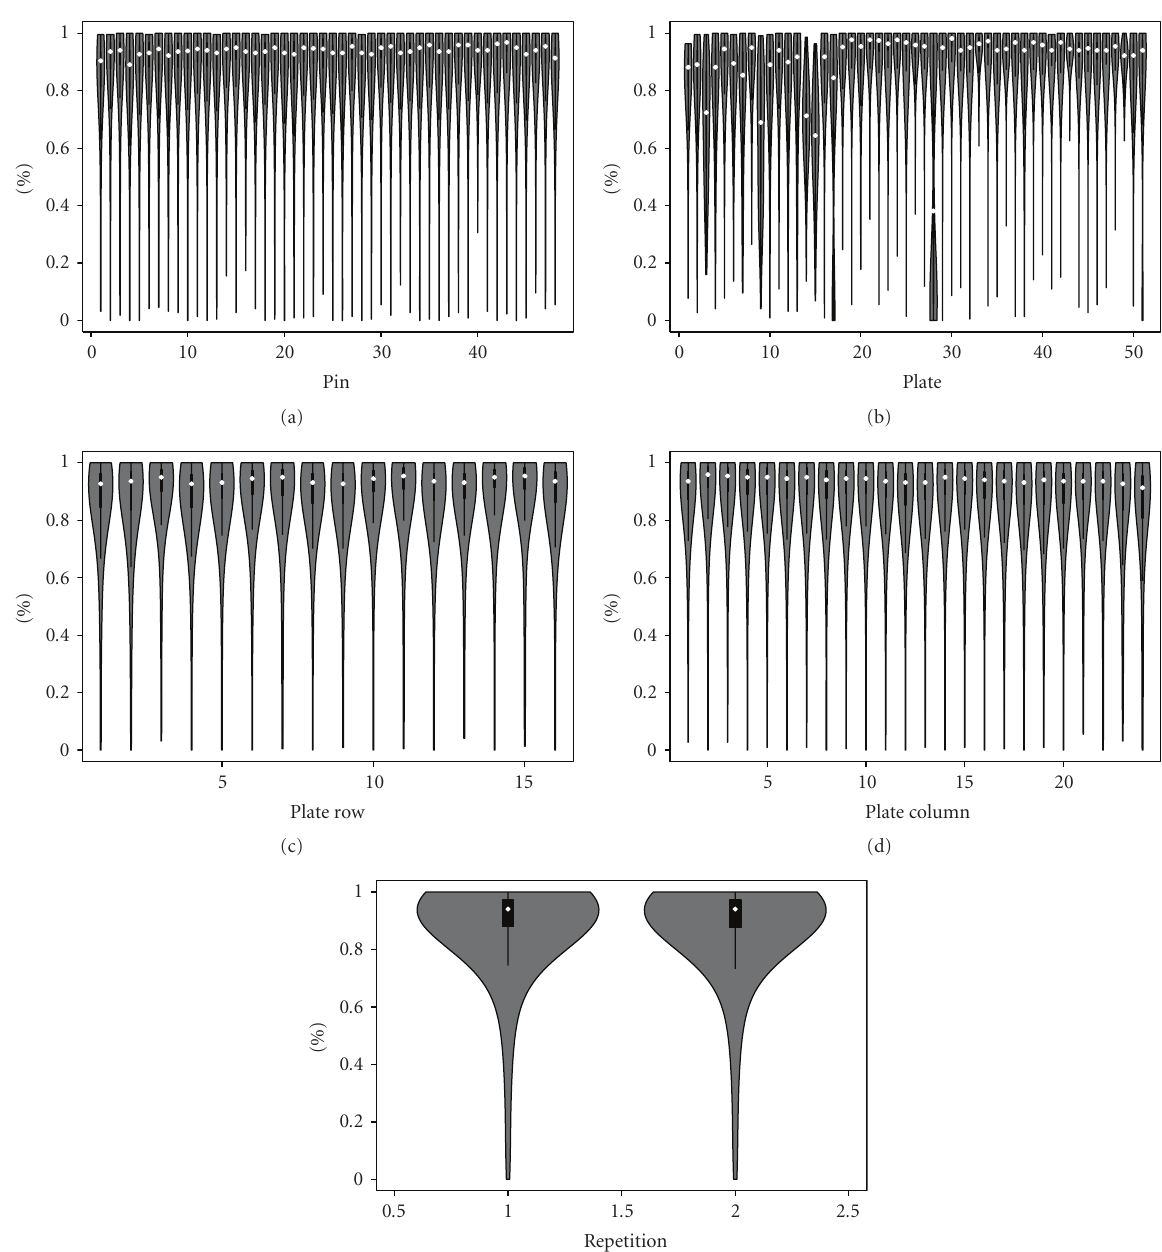
Figure 13: Violin plots for quality control: violin plots for quality control in the BAC aCGH spotting process. Each spot is evaluated according to the hybridization quality control. There were ∼ 200 samples comprising the experiment, and the percentage (over the number of samples) of times that each spot passed quality control was recorded. The violin plot in (a) shows the distribution of this percentage for each pin. The median is shown in white. The quality control for probes is assessed according to the (b) 384-well plates, (c) plate row, (d) plate column, and (e) repetition number for the BAC